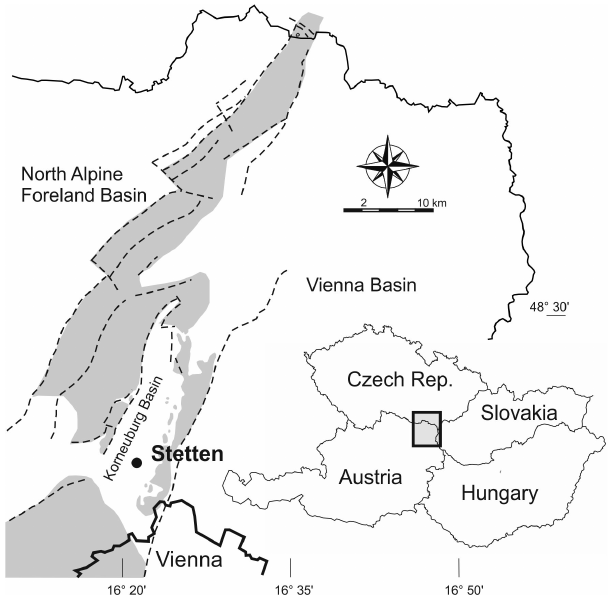
Figure 2. Geographic position of the Stetten site within the Ko- rneuburg Basin north of Vienna in Austria; shaded areas repre- sent pre-Miocene basement; dashed lines are major faults (modified from Dellmour and Harzhauser,